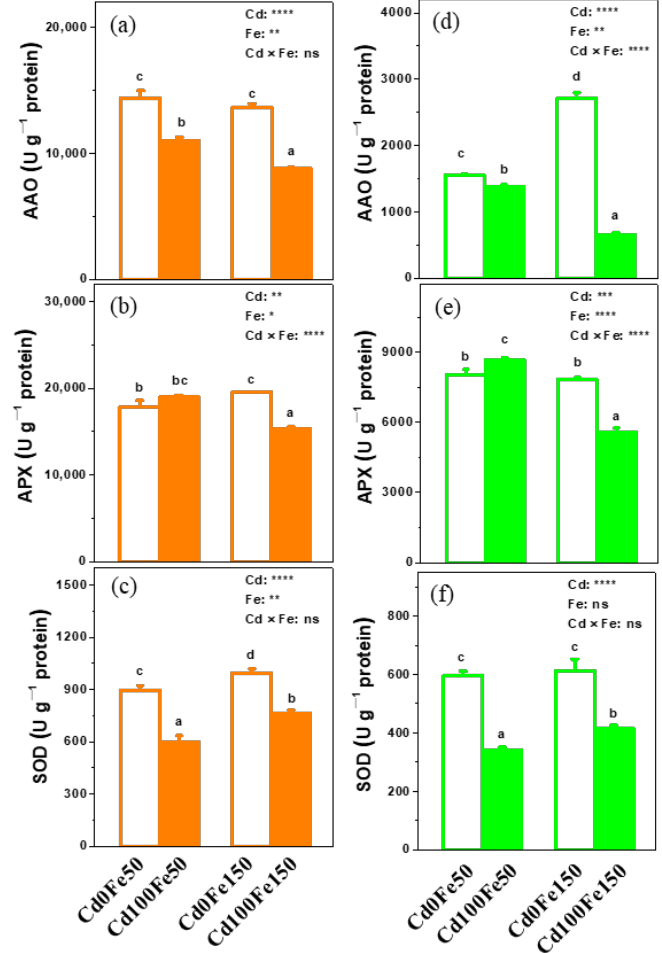
Figure 8. The activities of AAO ( a,d ), APX ( b,e ), and SOD ( c,f ) in the roots and leaves of poplar under different Cd and Fe combined treatments. Data were means ± SE (n = 6). Different lowercase letters on the bars indicate significant differences in ANOVA ( p < 0.05). p values of two-way ANOVA on Cd, Fe, and their interaction (Cd × Fe) were indicated (*, p < 0.05; **, p < 0.01; ***, p < 0.001; ****, p < 0.0001; ns, not significant).